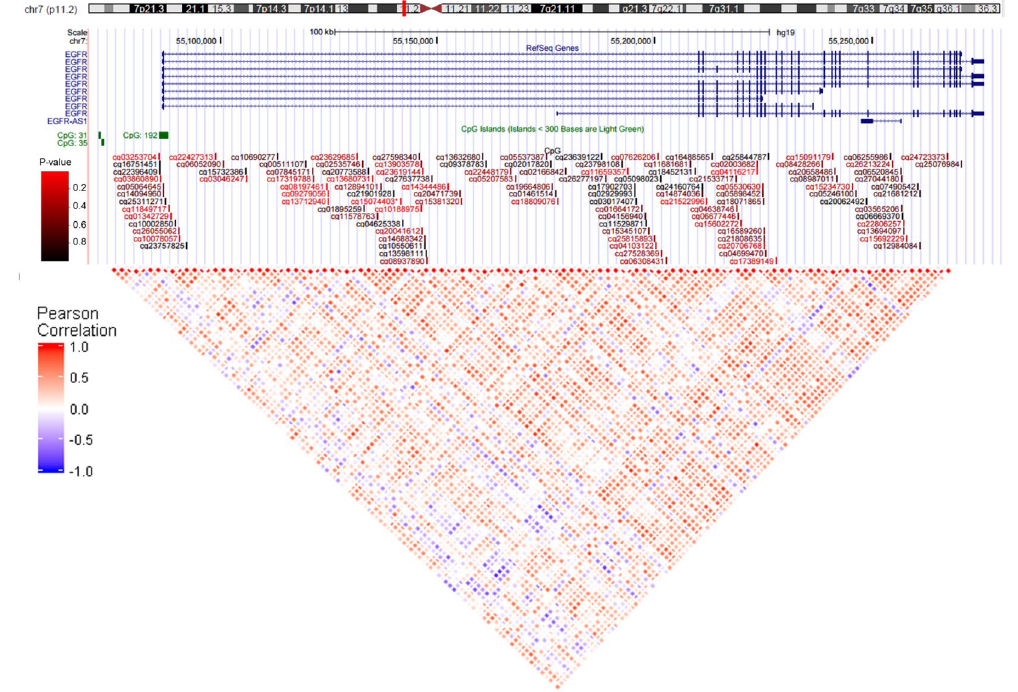
Figure 4. Location of CpG probes in EGFR. The colors of the probes reflect the significance and range from bright red (p-value < 0.005) to black (p-value = 0.99). A heatmap of the Pearson correlation values are shown below and the colors reflect the correlation coefficient with blue representing a coefficient of − 1 and red a coefficient of